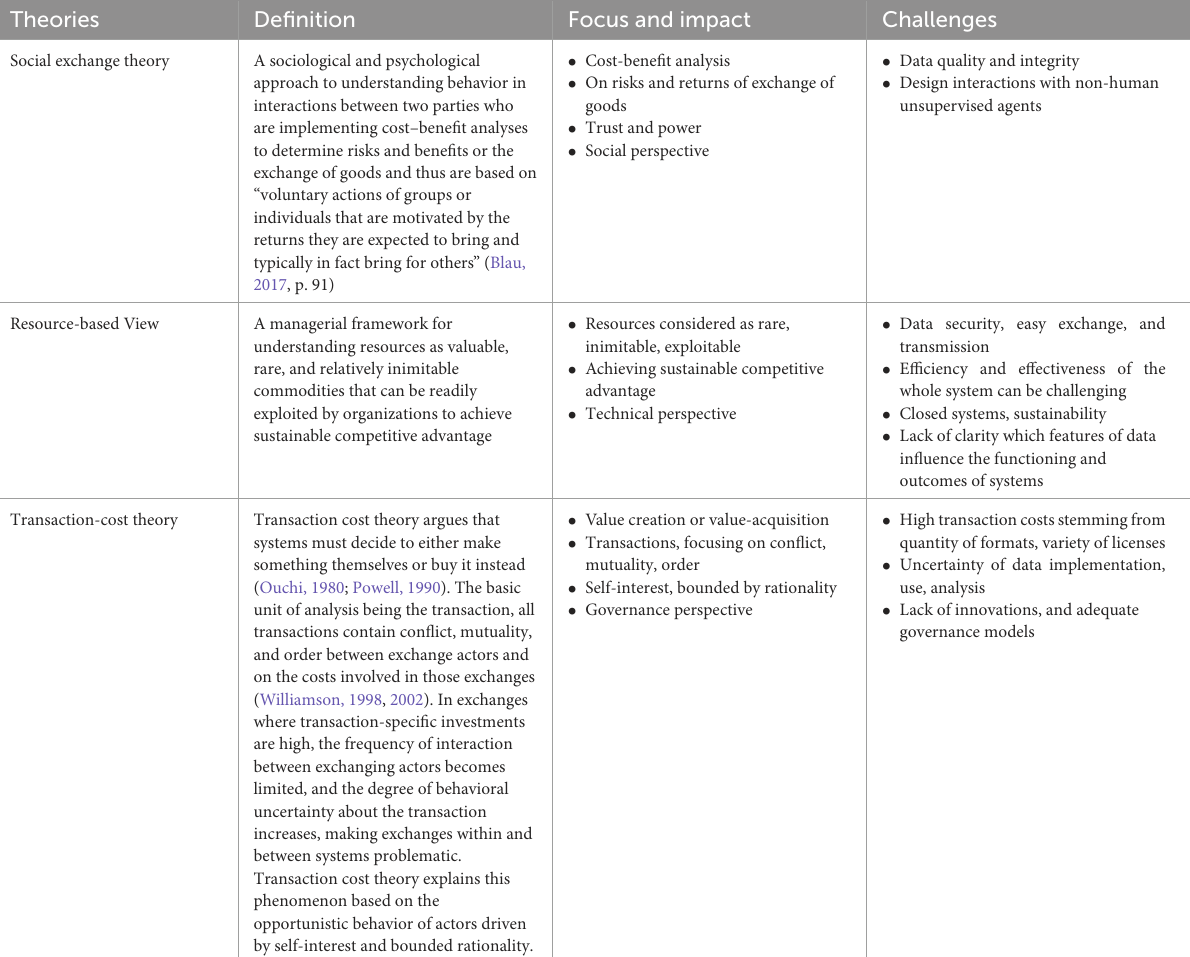
TABLE 1 Overview of the focus, impact, and challenges associated with three management theories applied to water management and infrastructure.